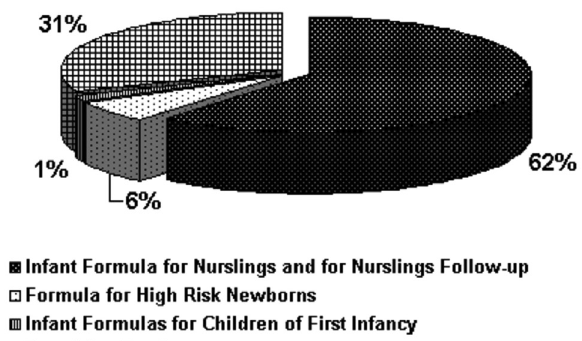
FIGURE 1 – Types of technical-scientific material.